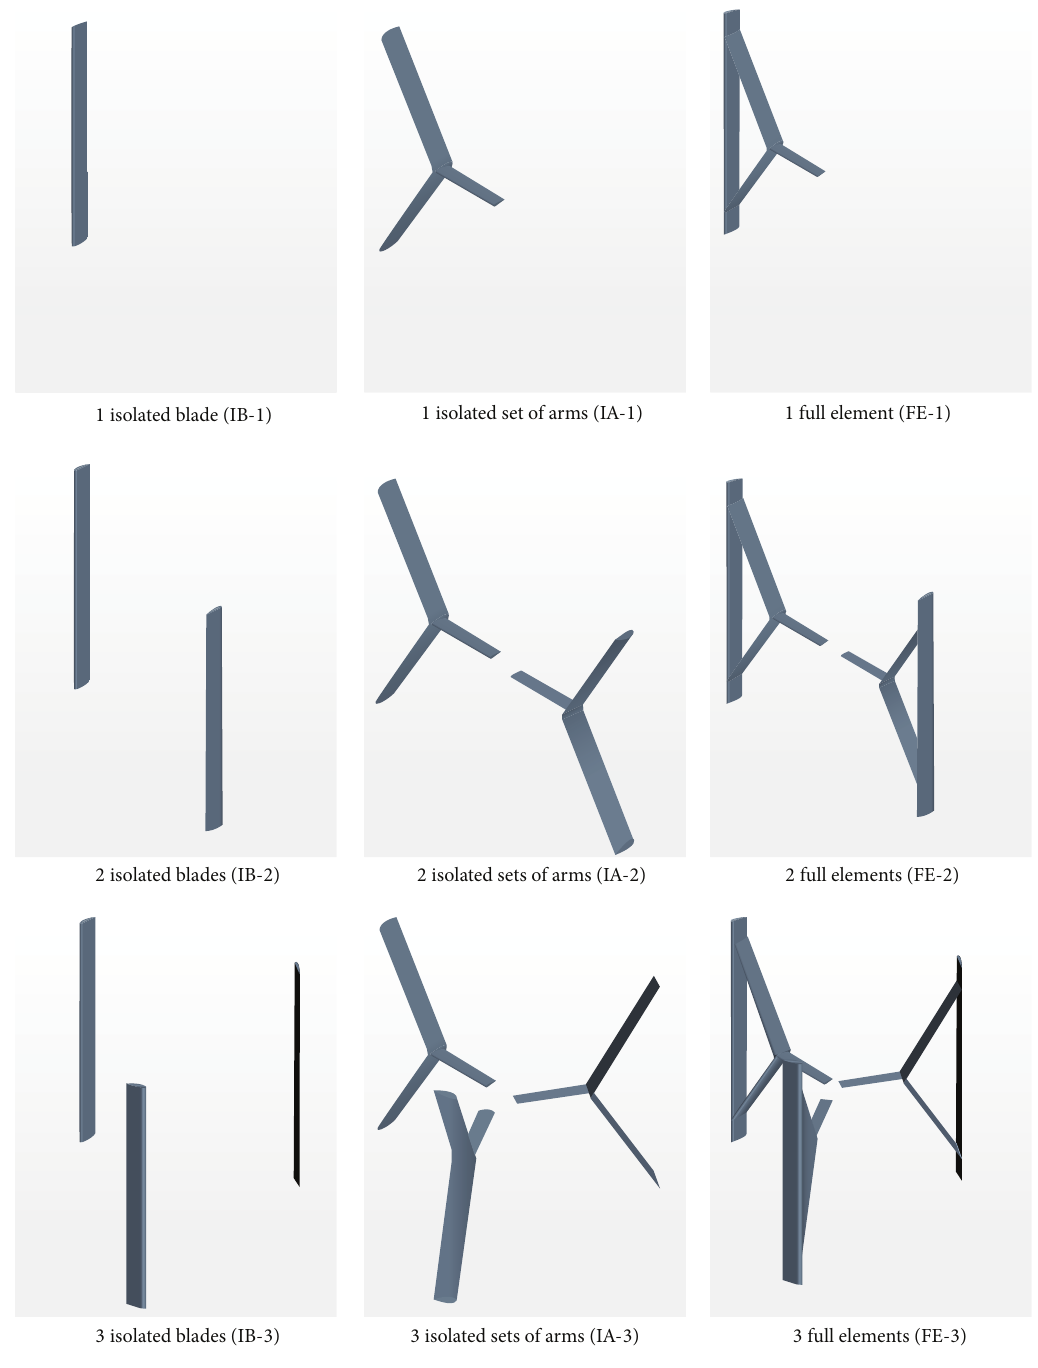
Figure 9: Isolated blades, isolated sets of inclined arms, and full elements analyzed in the